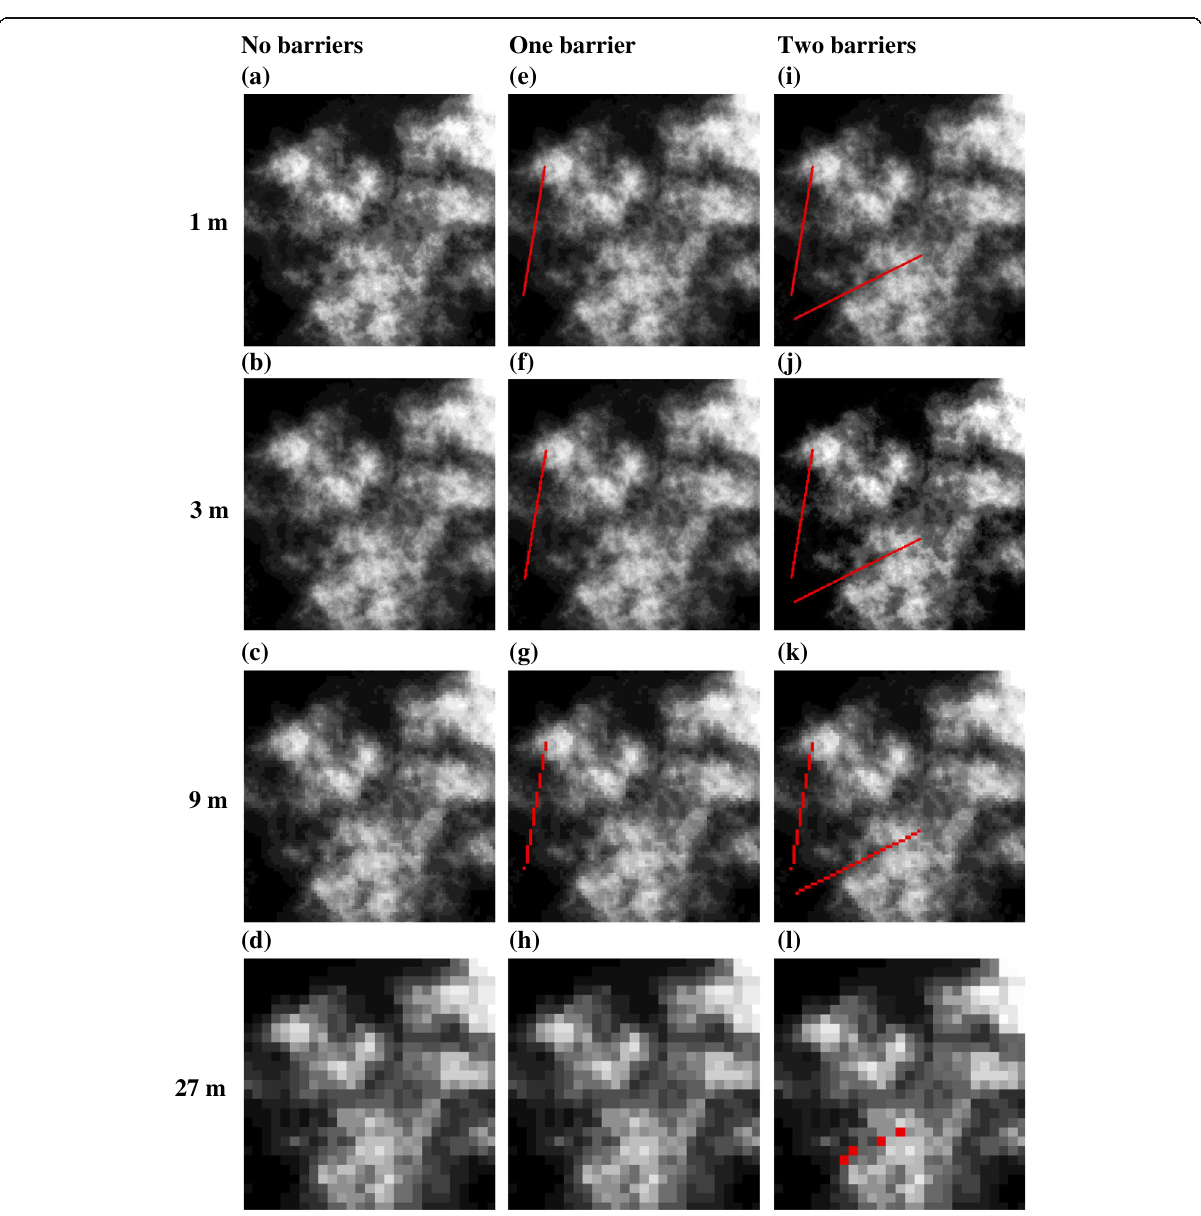
Fig. 2 Twelve cost surfaces with different resolutions and different numbers of linear barriers (colored in red) derived from a common neutral landscape model. Note that darker shades represent higher cost values. Note also that (parts of) some linear barriers have disappeared at lower